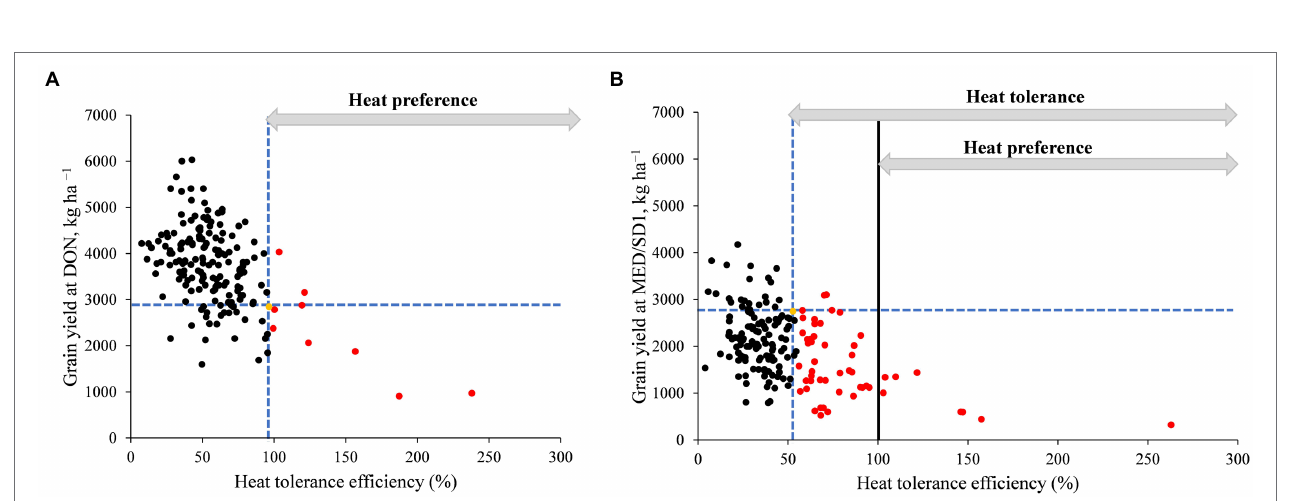
FIGURE 3 | Grain yield (GY) versus heat tolerance efficiency (HTE). (A) GY at Dongola (DON) versus HTE calculated using the GY of DON as the cool environment and that of Wad Medani for the first sowing date (MED/SD1) as the hot environment (referred to as HTE1 in the text). (B) GY at MED/SD1 and HTE calculated using the GY of MED/SD1 as the cool environment and that of Wad Medani for the second sowing date MED/SD2 as the hot environment (referred to as HTE2 in the text). The yellow dot indicates the values for ‘Miki 3’. Black dots denote MDLs with HTE less than that of ‘Miki 3’. Red dots denote MDLs with HTE higher than that of ‘Miki 3’. Dashed blue lines intersect on ‘Miki 3’. Vertical black line marks HTE = 100. Horizontal grey arrows denote the ranges of heat tolerance and heat